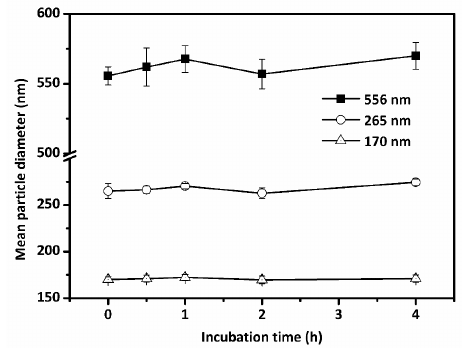
Figure 4. Stability of three different mean droplet size emulsions (556, 265, and 170 nm, respectively) during 4 h incubation in PBS (pH 7.4) at 37 °C. Stability was evaluated by the mean droplet diameter changes of emulsions measured at several incubation intervals (0, 0.5, 1, 2, and 4 h).